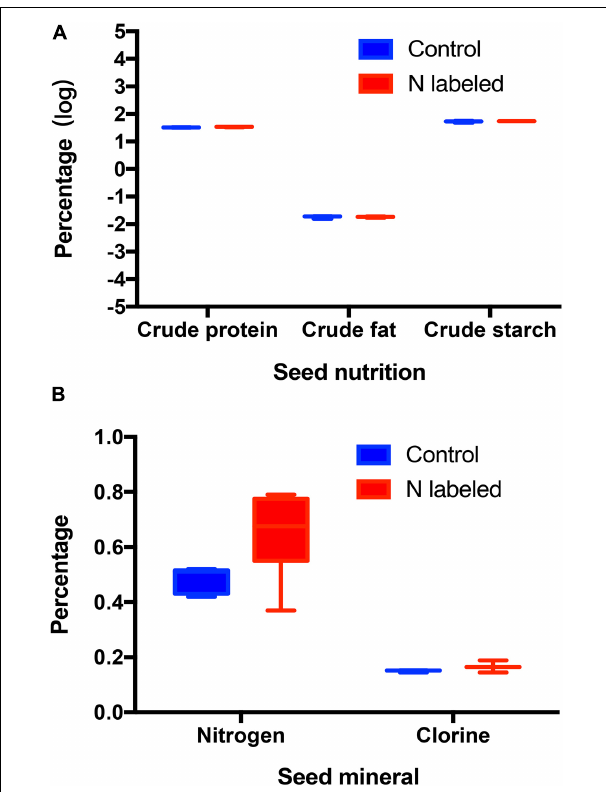
FIGURE 2 | Effects of xylem injection of 15 NH 4 Cl and K 15 NO 3 on acorn nutrition (A) and minerals (B) .